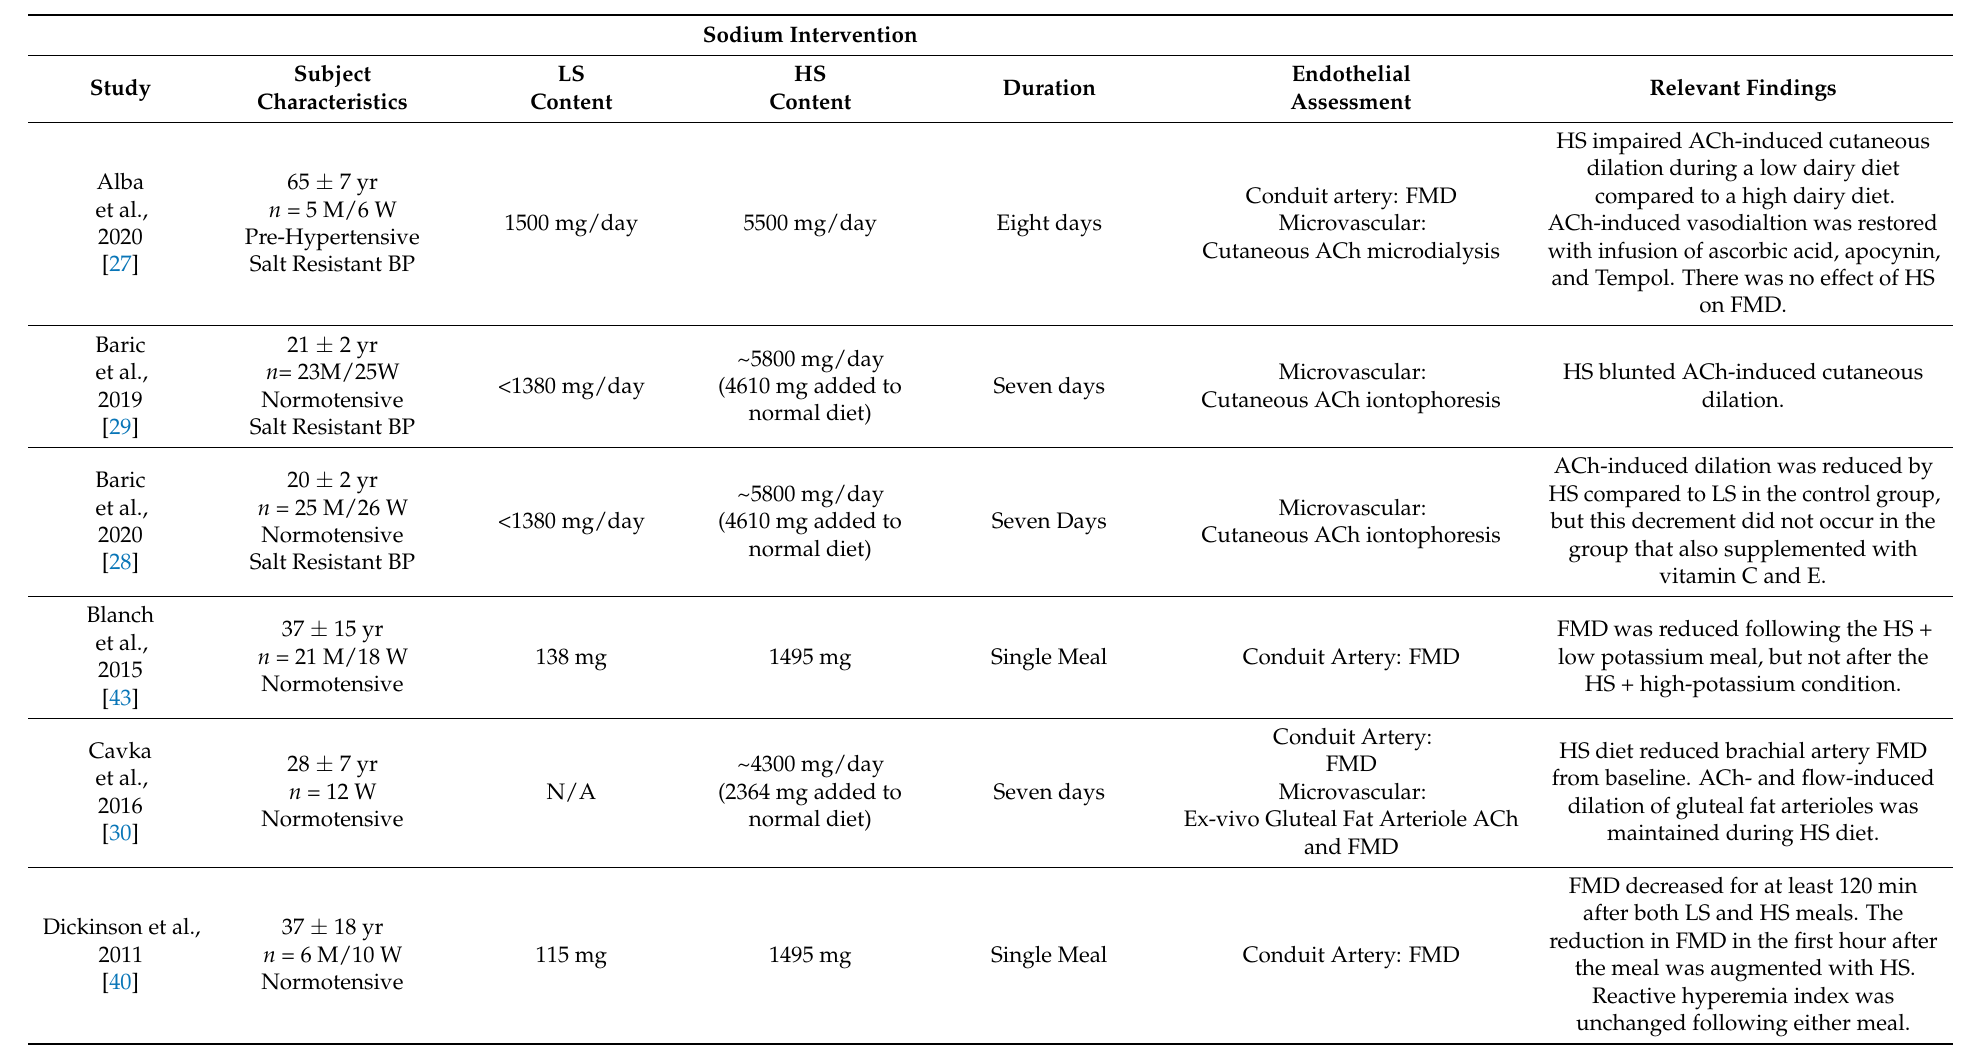
Table 1. Summary table of studies that have investigated the effects of dietary sodium on endothelial